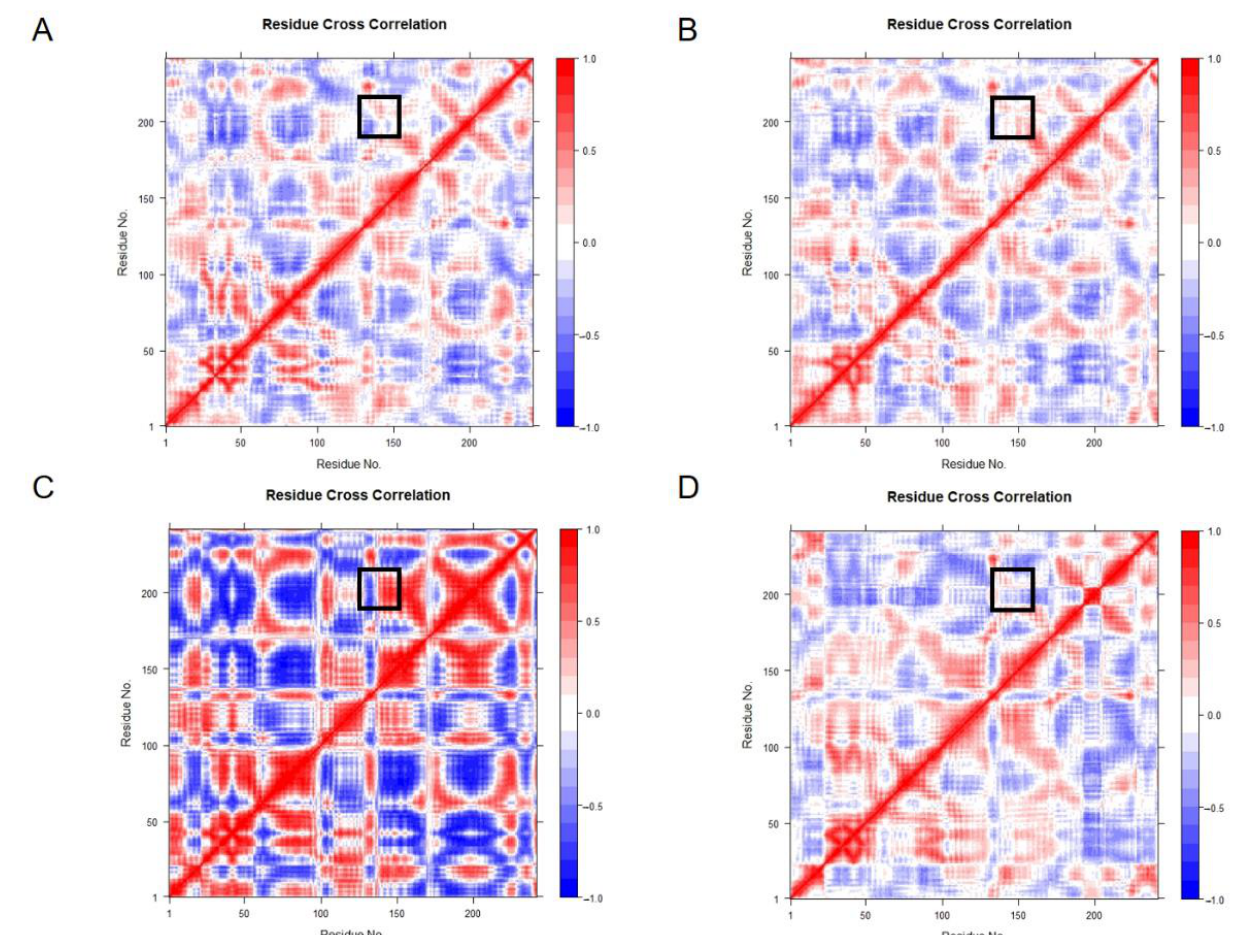
Figure 10. Correlation diagram of residue covariance used to mark the interaction positions of segments Ile145-Gly148 and His198-Val208 with black rectangles: ( A ) 7C6C-Free; ( B ) 7C6C-(GlcN) 2 ; ( C ) G21K-(GlcN) 2 ; ( D ) G21R-(GlcN) 2 .